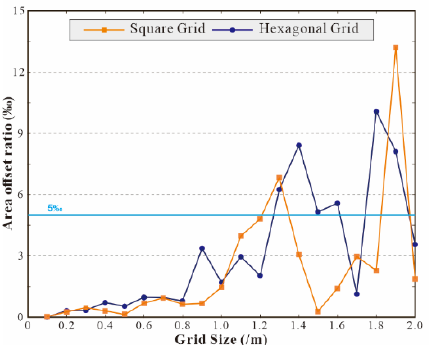
Figure 15. Diagram of the deviation from the true value of the channel area (10001).